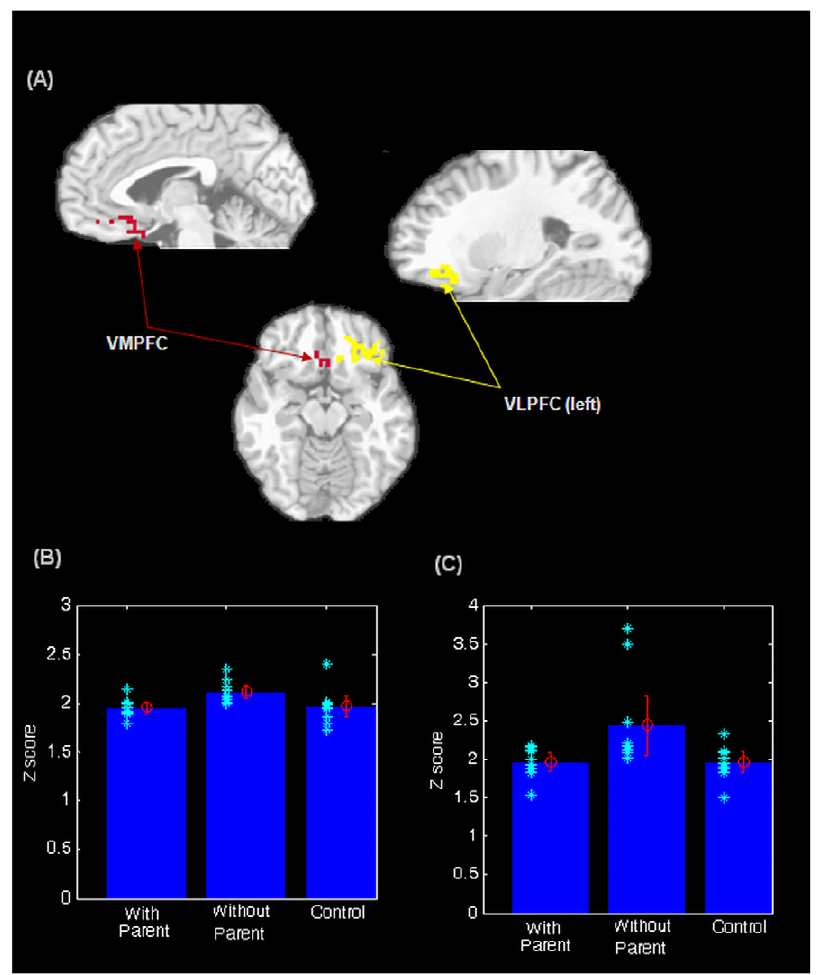
Figure 2. a . Significant differences observed in ventral prefrontal regions (VMPFC and VLPFC-left) among anxious with caregiver group, anxious without caregiver group and controls. b . Z-scores of VMPFC activity among anxious with caregiver group, anxious without caregiver group and controls. c . Z-scores of VLPFC-left activity among anxious with caregiver group, anxious without caregiver group and controls.